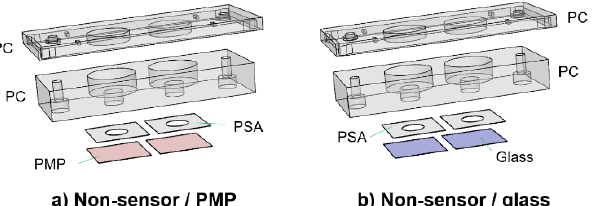
Figure 3. Culture chamber devices without oxygen sensors. Two devices used for the comparison of cell adherence, proliferation and viability (Section 2.5). The only difference from the devices in Figure 2 is in the design of the lids, which are here only support covers to ensure sterility (referred to as “non ‐ sensor lids”). These were designed with either a PMP film ( a ) or a glass coverslip ( b ) for the bottom part of the culture